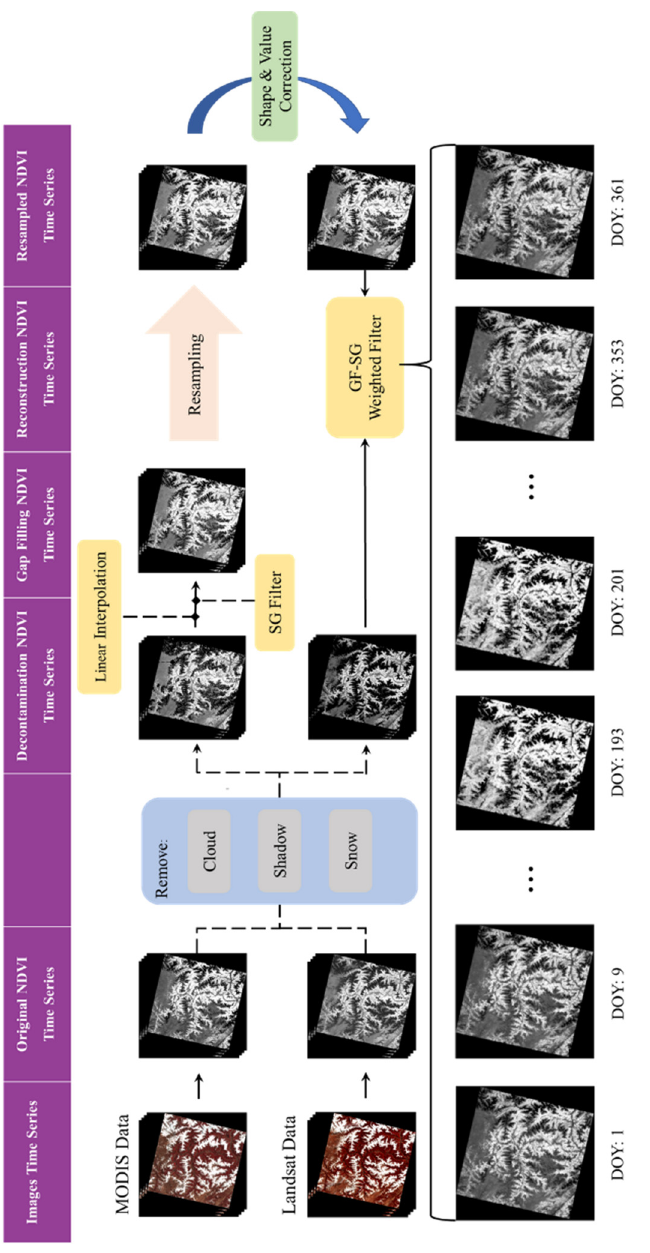
Figure 2. Flowchart used to reconstruct continuous Landsat NDVI time-series data for the QTP region.